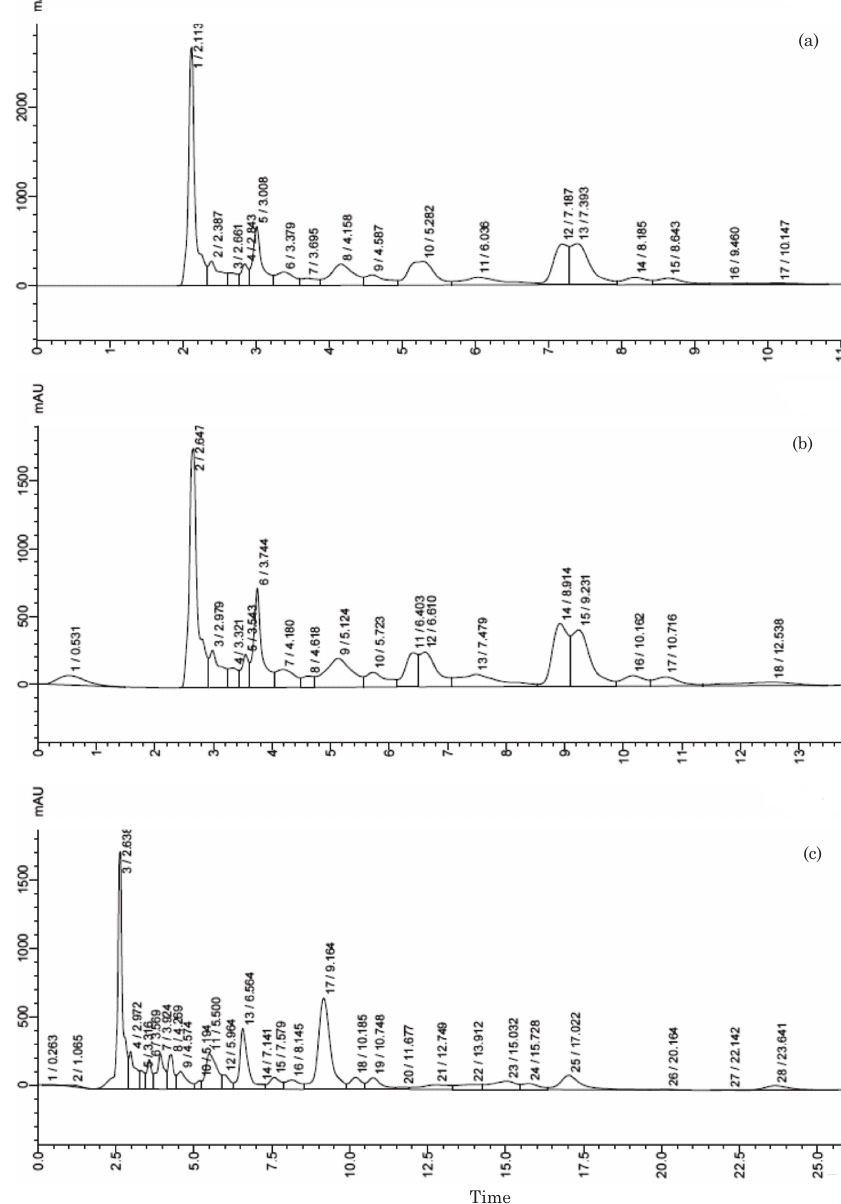
Figure 2. Chromatograms of vinasse sample at different run times: (a) 11 min, (b) 14 min, and (c) 25